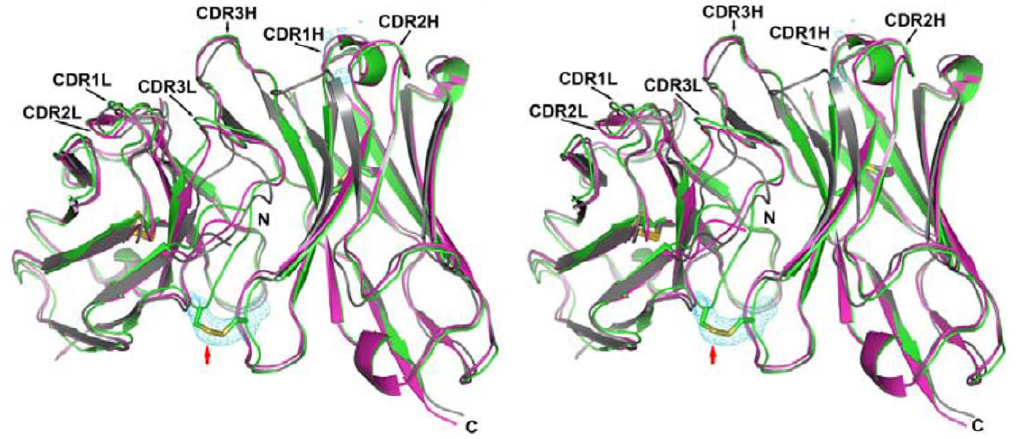
Figure 2. The crystallographic structure of the sc-dsFv derived from G6-Fab. The sc-dsFv structure (colored in green, PDB code 3AUV) is superimposed with the variable domains of VEGF-complexed G6-Fab (2FJG in PDB code, colored in grey) and unbound G6-Fab (2FGF in PDB code, colored in magenta). The interface disulfide bond in the sc-dsFv is marked with the arrow. The RMSDs between the sc-dsFv and the variable domains derived from 2FJF and 2FJG are 0.629 A˚ and 0.942 A˚, respectively. The model of the interface disulfide bond in the sc-dsFv is shown with the superimposition of the Fo-Fc simulated annealing omit density map (colored in cyan) at the 5.0 s level. The omit density map was calculated without the residues of the interface cysteins. The refinement data for the sc-dsFv structure determination are shown in Table S3.